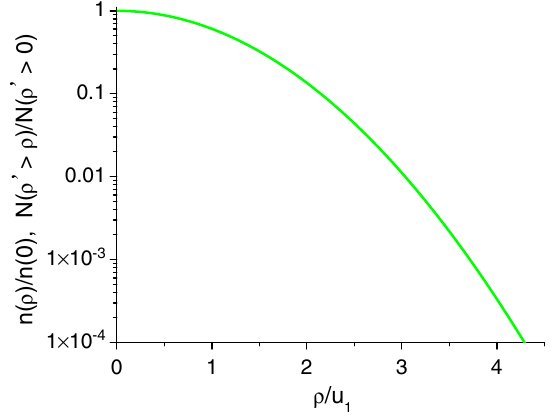
FIG. 5. Radial dependence of both the nuclear number density (2) and, proportional to the latter, number of the nuclei, situated at the radial distances ρ 0 > ρ , exceeding the plotted ρ value, both measured in units of their maximum values reached at ρ ¼ 0